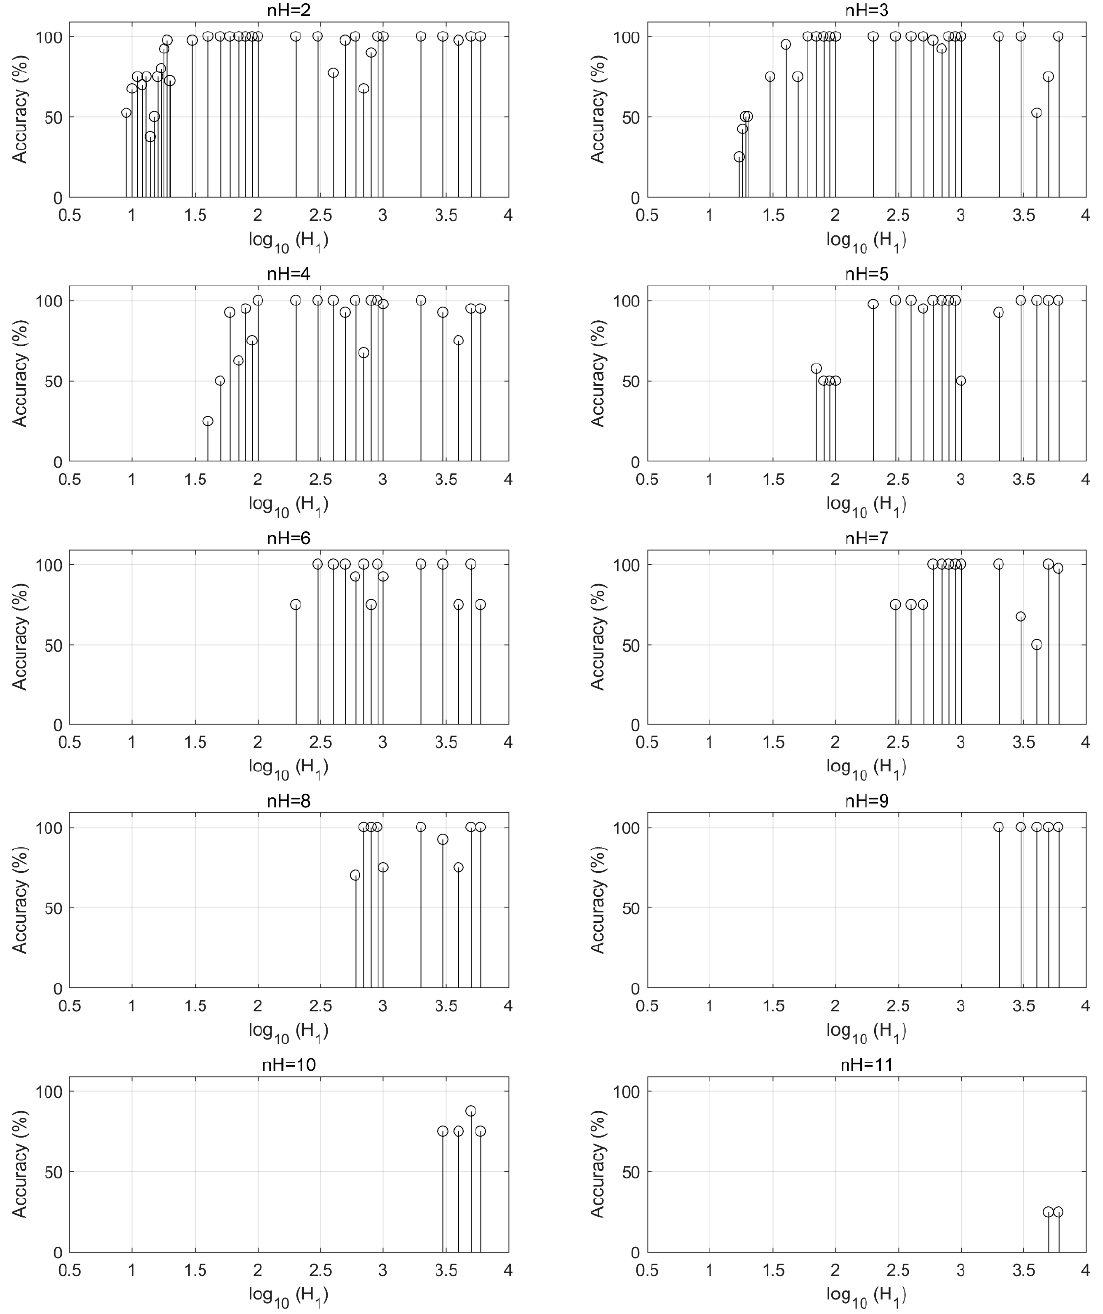
Figure 9. Accuracies of ANN models in the change of the number of hidden layers.